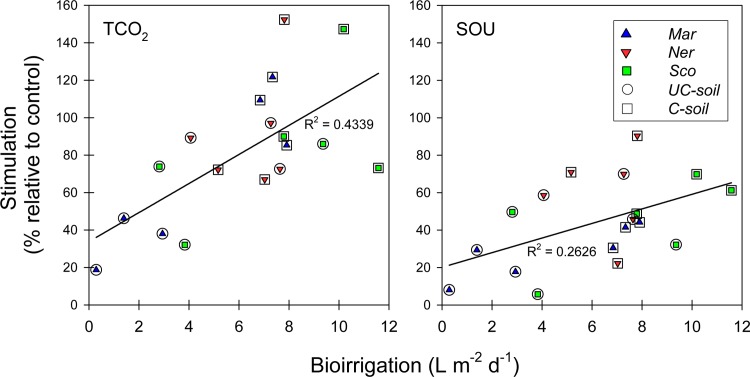
Linear regressions between the relative stimulation of TCO2 efflux and sediment O2 uptake (SOU) and bioirrigation intensity in flooded uncultivated (UC) and cultivated (C) soils with polychaetes added (Mar: Marenzelleria viridis, Ner: Nereis diversicolor and Sco: Scoloplos armiger).